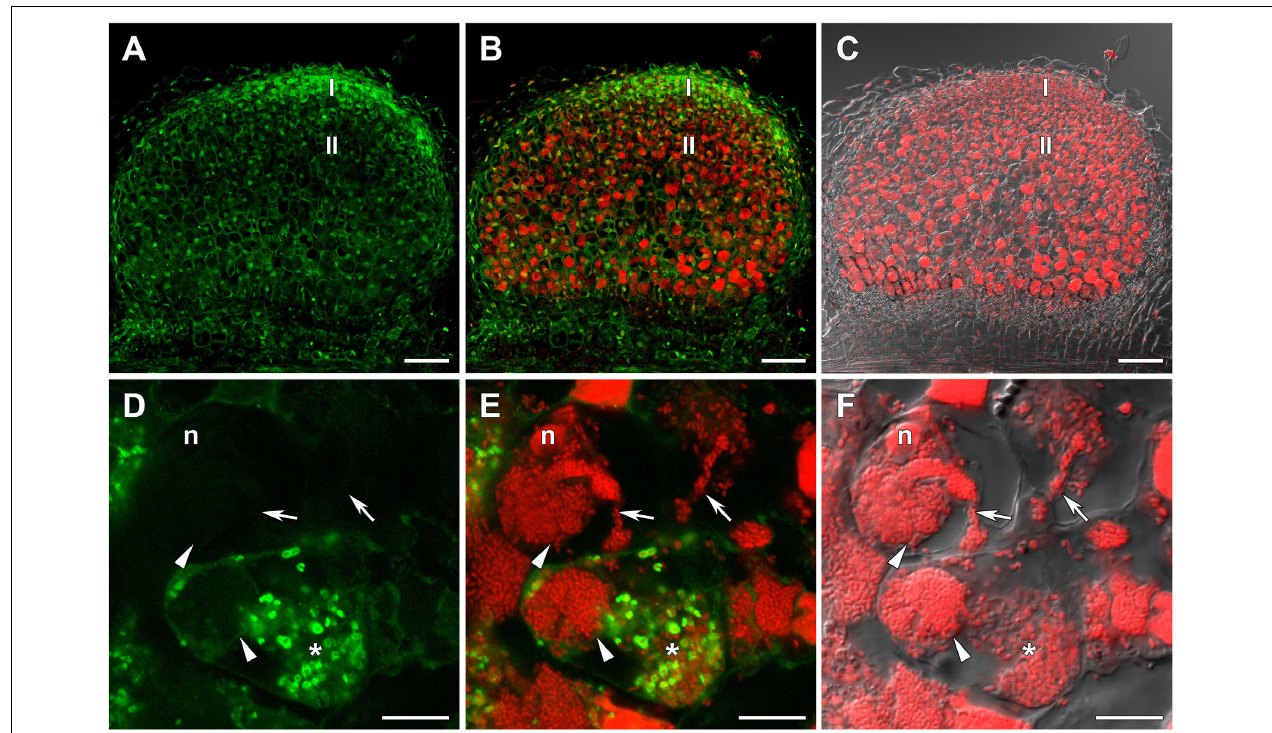
FIGURE 2 | Immunolocalization of glutathione in 3-week-old nodules of the pea ( Pisum sativum ) sym40-1 mutant using a rabbit anti-glutathione (reduced) antibody. (A–C) General view; (D–F) infected cells. (A,D) Green channel; (B,E) merge of the green and red channels; (C,F) merge of differential interference contrast and the red channel. Confocal laser scanning microscopy images of 50- µ m-thick longitudinal sections. A single optical section is presented, glutathione in green and DNA (bacteria and nuclei) in red. I, meristematic zone; II, infection zone; n, nucleus; *, released bacteria. Arrows indicate infection threads; arrowheads indicate infection droplets. Scale bars = 100 µ m (A–C) and 10 µ m (D–F)